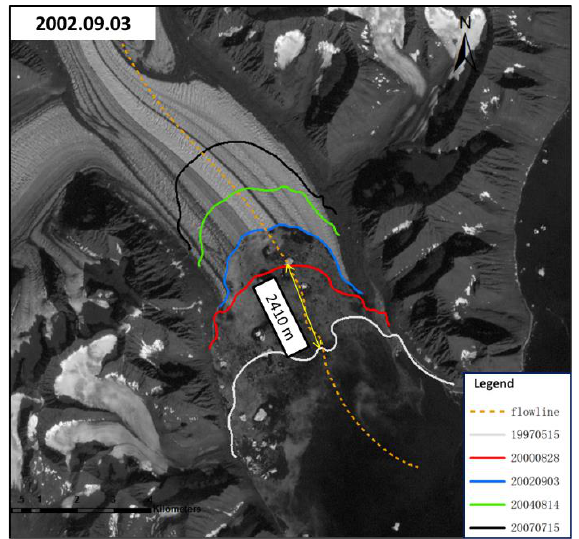
Figure 6 . Sortebræ Glacier, central East Greenland. Ice front location from May 15, 1997 (Gray) to July 15, 2007 (Black) Background image is Landsat 7 ETM+ image (bands 8; September 3, 2002). Dashed Seville Orange lines the central